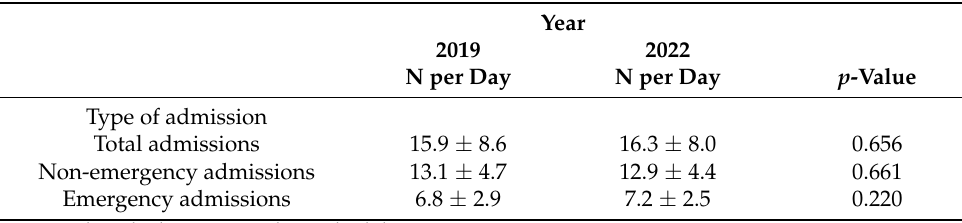
Table 4. Comparison of the number of hospital admissions and invasive cardiac procedures per day in 2019 and 2022 (1 January–30